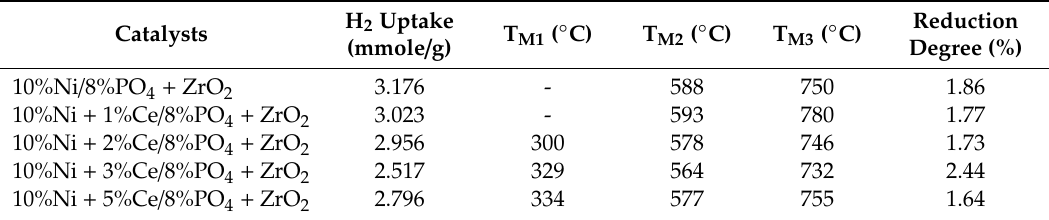
Figure 3. TPR-H 2 profiles of the reduced catalysts calcined at 600 °C. Table 2. TPR data of the studied catalyst samples in terms of amount of H 2 consumption and temperature of peak maxima (T M